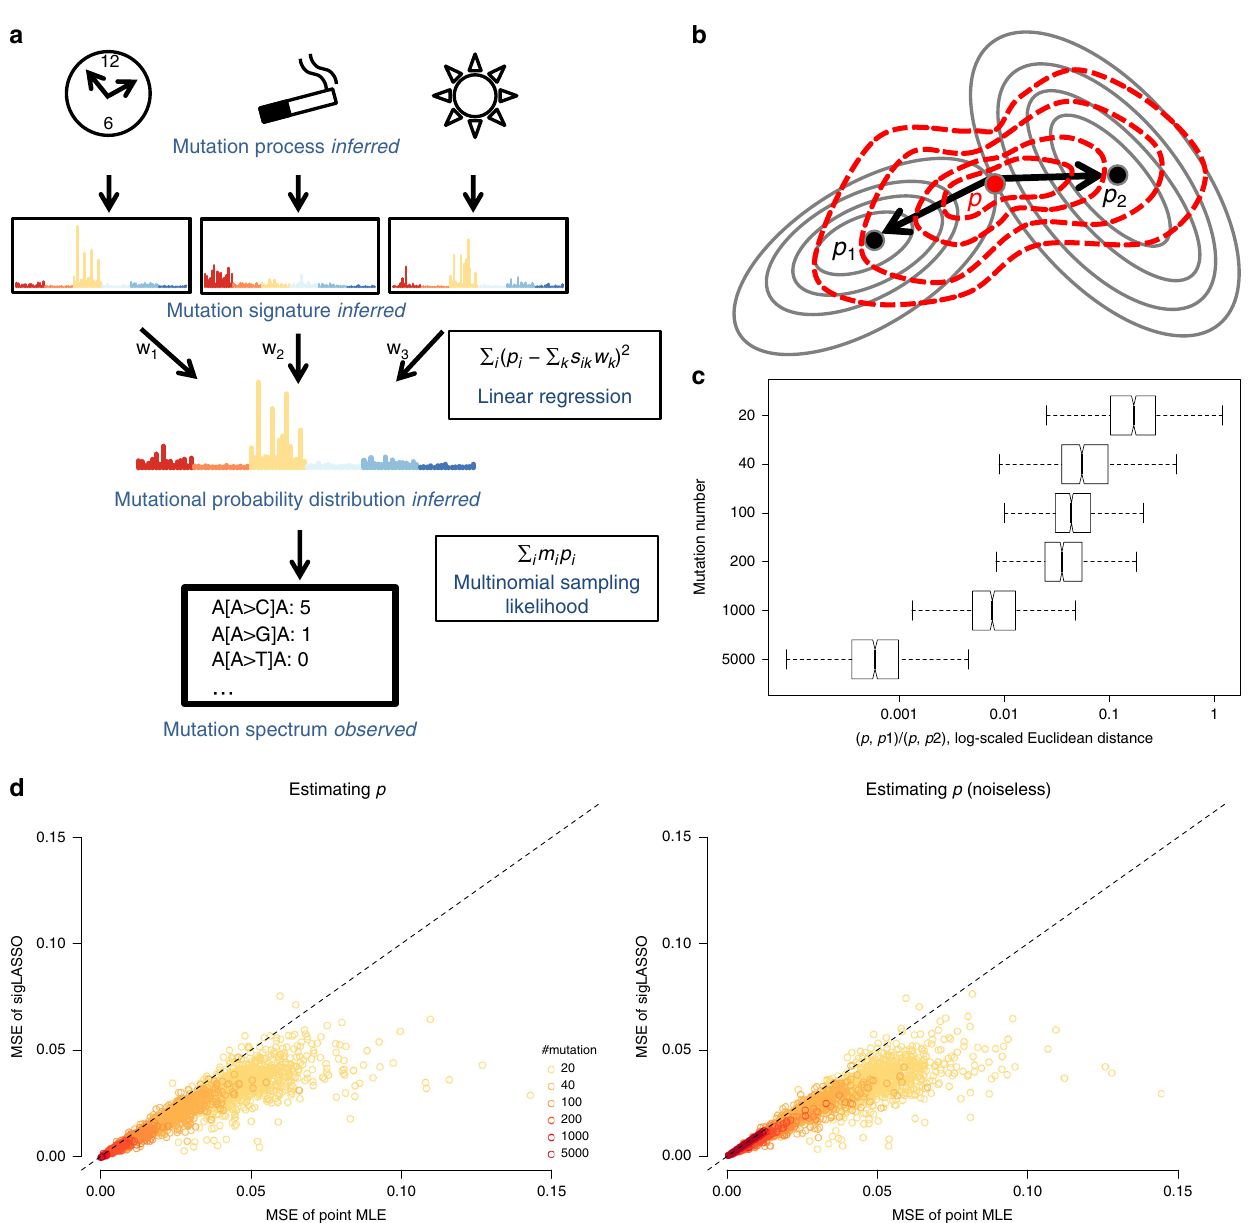
Fig. 1 SigLASSO takes sampling variance into account. a A schematic graph showing the mixture model of mutational processes and signatures. b A contour plot of the penalty function of multinomial sampling function (optimum at p 1 ) and the least square of signature fi tting (optimum at p 2 ). sigLASSO tries to jointly optimize both penalties (red contour lines, optimum at p ). c As mutation number increases, the inferred p ! gets closer to the sampling MLE rather than the linear fi tting as the sampling variance decreases. Box edges are the 25th and 75th percentiles and whiskers indicate the 1.5× interquartile range (IQR) or max/min, which ones are smaller. d The MSE of the estimation of p ! and the underlying noiseless signature mixture by sigLASSO and using the point MLE. Low mutation counts pro fi les bene fi t from sigLASSO the most. Priors were sampled uniformly from the ground true positives and